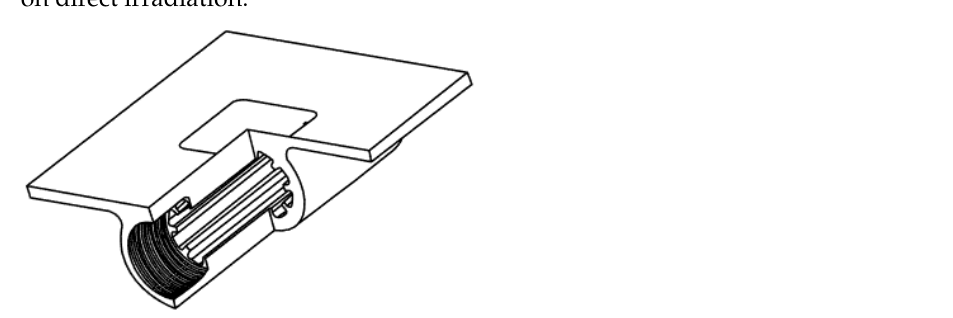
Figure 12. The cross-sectional view of typical triangular-duct heat receiver. The studies described in [95] proposed a new receiver geometry for the parabolic trough CPVT system: a triangular channel with two walls covered with monocrystalline silicon cells and thermoelectric generators (TEG), whereas the third wall was insulated (see Figure 13). The construction tracked the Sun's position along the N–S axis. The daily operation revealed an average electrical efficiency of 4.83% (0.16% for TEG and 4.67% for PV) and thermal efficiency of 46.16% for the system with a glass cover. After the glass cover was removed, the thermal efficiency dropped to 42.36%, whereas electrical perfor- mance was raised to 4.94% (0.12% TEG and 4.82% PV). The authors noticed the significant optical dissipations through the receiver, which caused the relatively low electrical effi- ciencies.